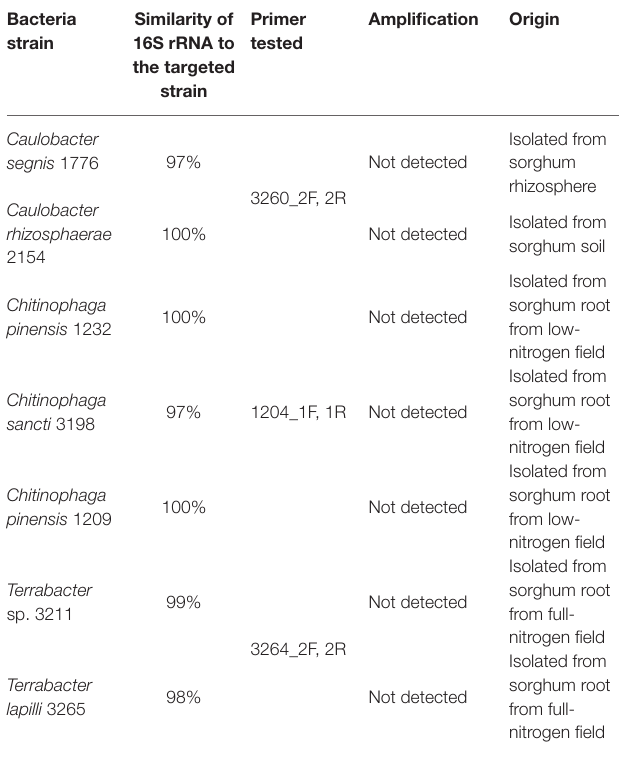
TABLE 2 | Bacterial strains used to test the specificity of each primer